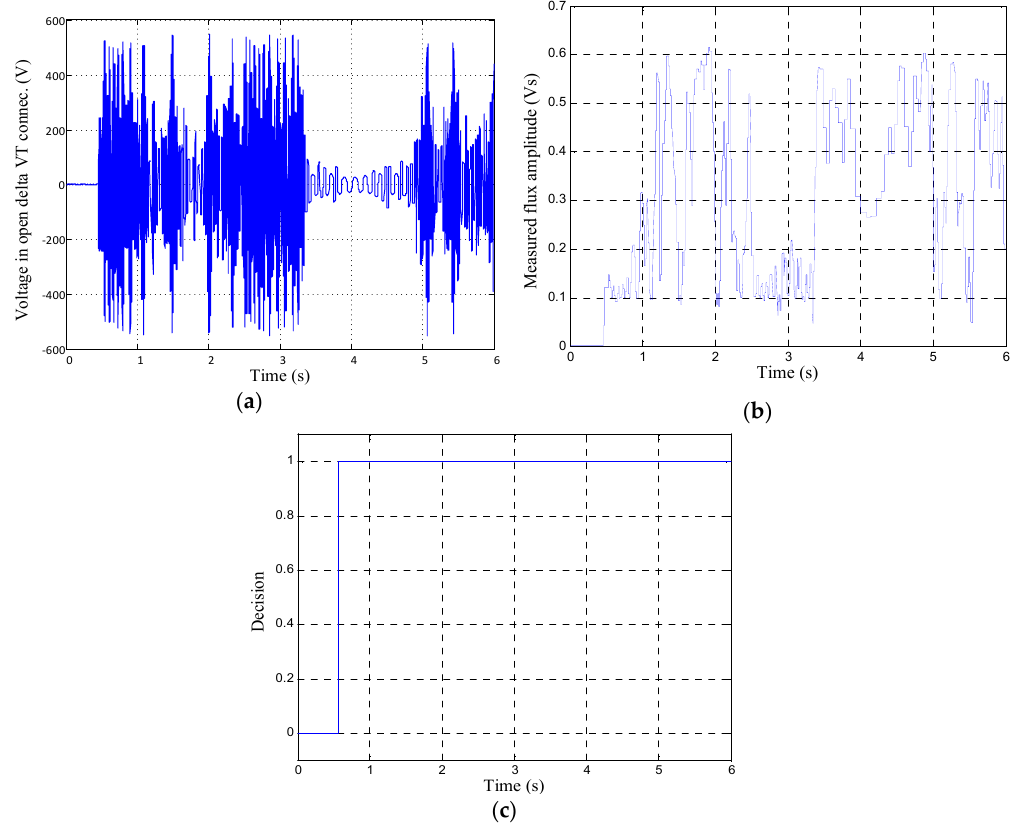
Figure 8. Ferroresonance due to transient fault in an ungrounded neutral system for X c / X m = 6.3: ( a ) voltage in open delta VT connection; ( b ) measured flux amplitude; ( c ) proposed algorithm operation.